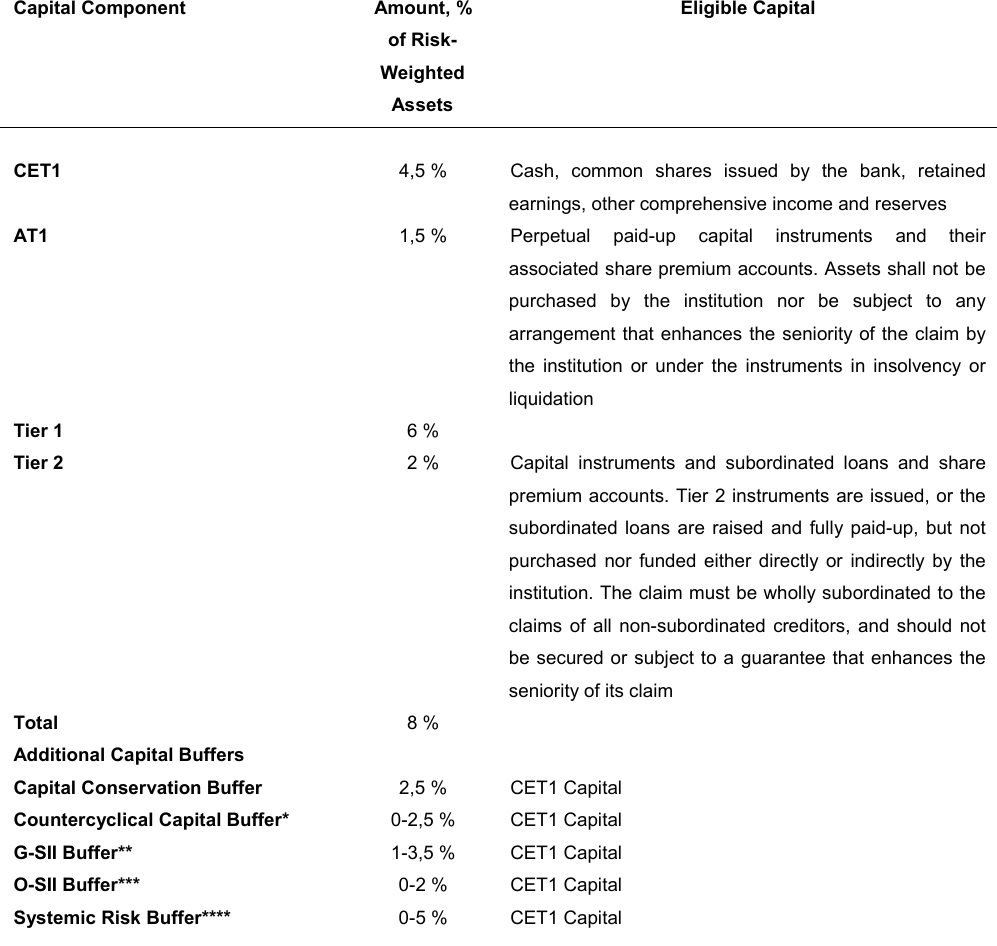
Table 1. A review of the CRD IV capital rules. Capital